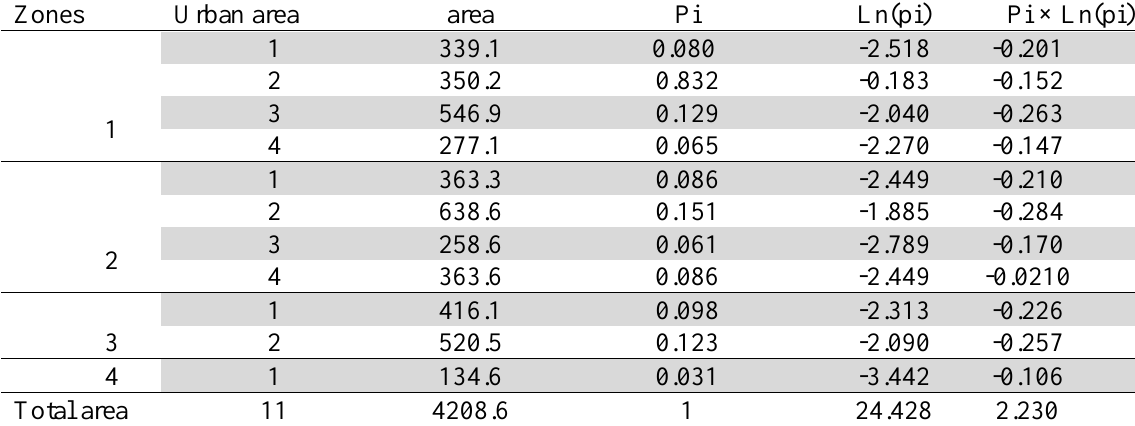
Calculation of the Shannon entropy for 1389 (2010) in